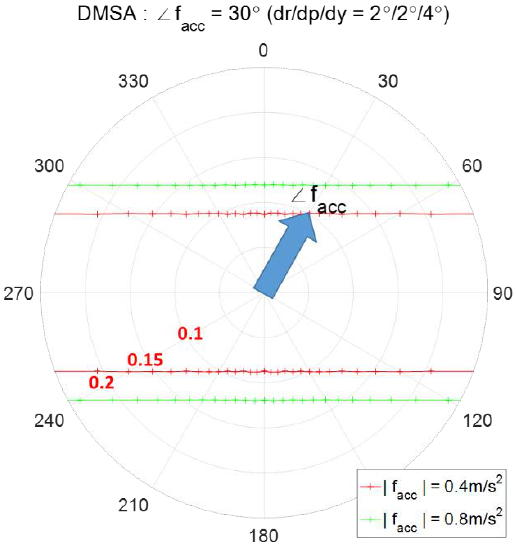
Figure 13. Contour of DMSA using the decision variable 𝑍 𝑎𝑏𝑠𝑁 ( ∠ 𝐟 𝐚𝐜𝐜 = 30° ), the angle denotes the direction of 𝒇 𝒔 , i.e., ∠ 𝒇 𝒔 .